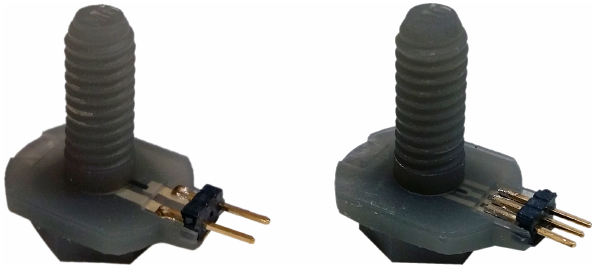
Figure 6. Photograph of ABS Flex screws with an integrated sensor foil element; some misalignment of the sensor foil is evident on the left screw.